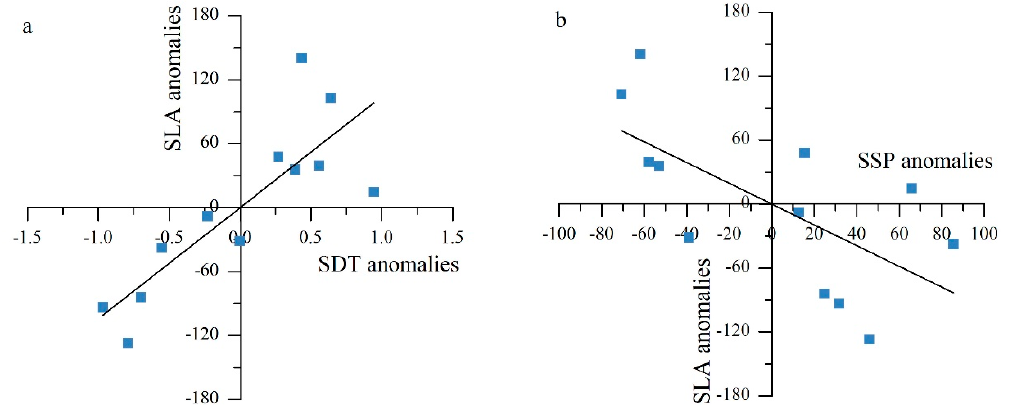
Figure 11. Mean snow line altitude (SLA) anomalies (in m) for all study glaciers plotted versus summer daily temperature (SDT) anomalies (in ℃ ) (a) and cumulative summer solid precipitation (SSP) anomalies (in mm) (b). Here, each dot represents one year during 1994–2016. The solid precipitation threshold was 2.8 °C .